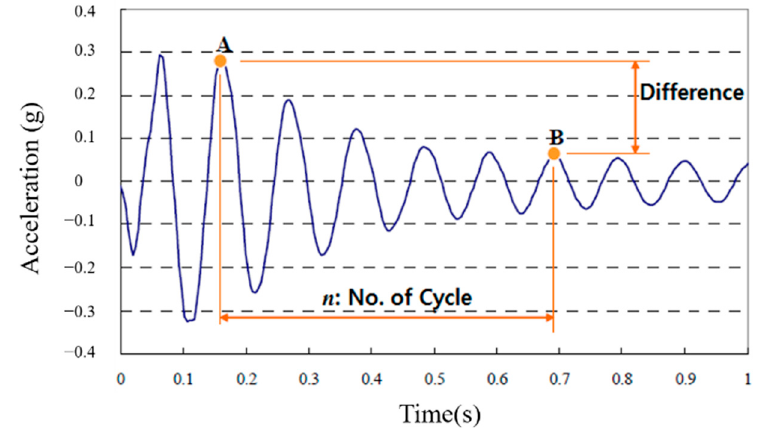
Figure 3. Logarithmic decrement.